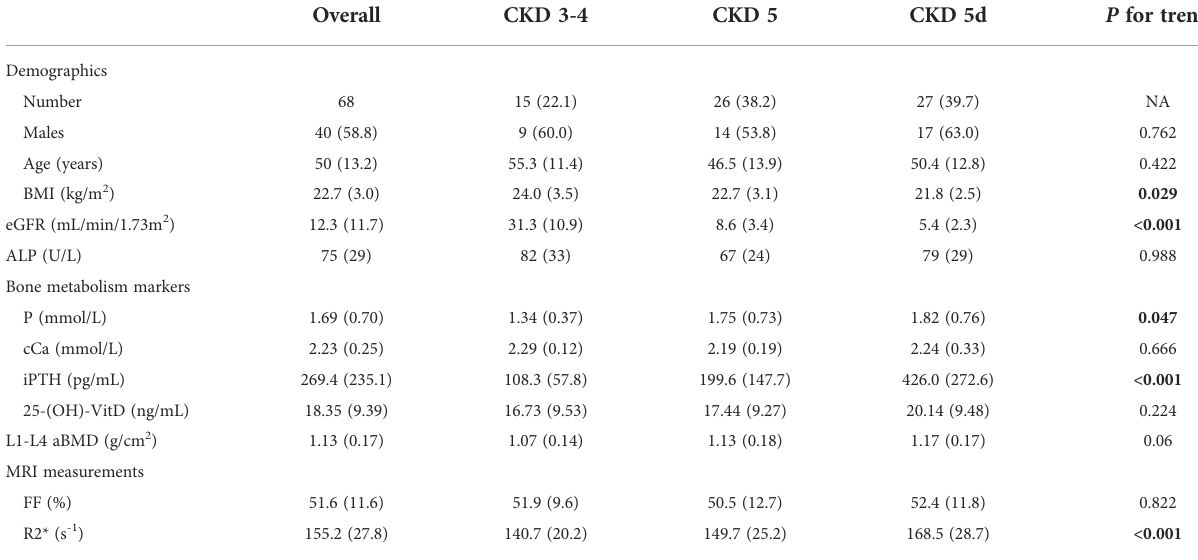
TABLE 1 Baseline characteristics among three groups (CKD 3-4, 5, and